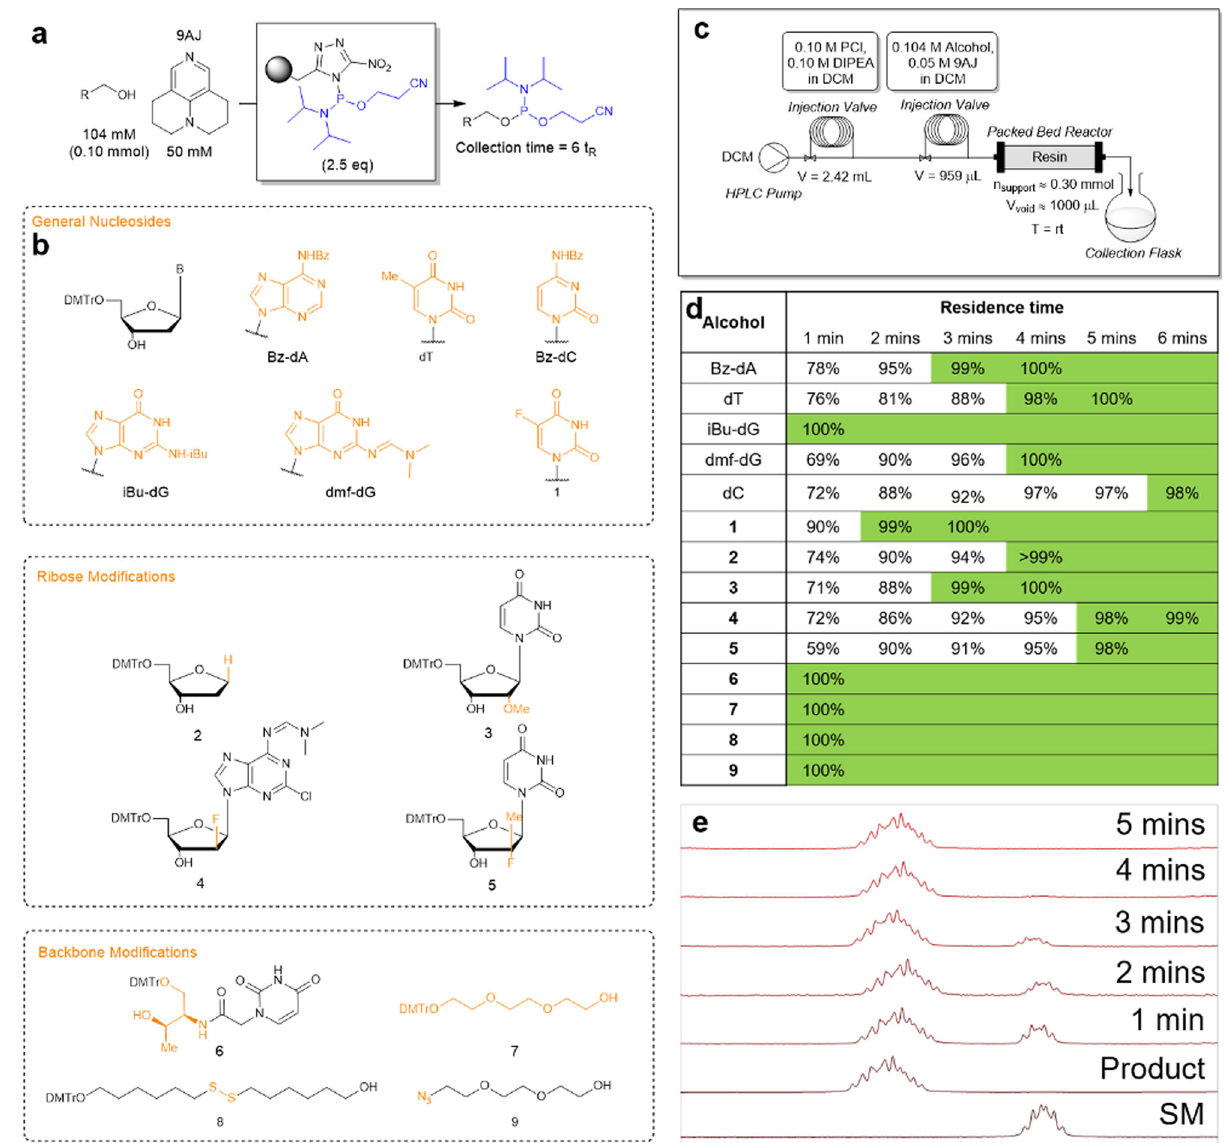
Fig. 3 Residence time study. a General reaction scheme for the residence time study. b Structure of the 14 alcohols. c Schematic representation of the fl ow setup. d Residence time yields for the different alcohols based on the amount of product and starting material. Yields ≥ 98% have been highlighted in